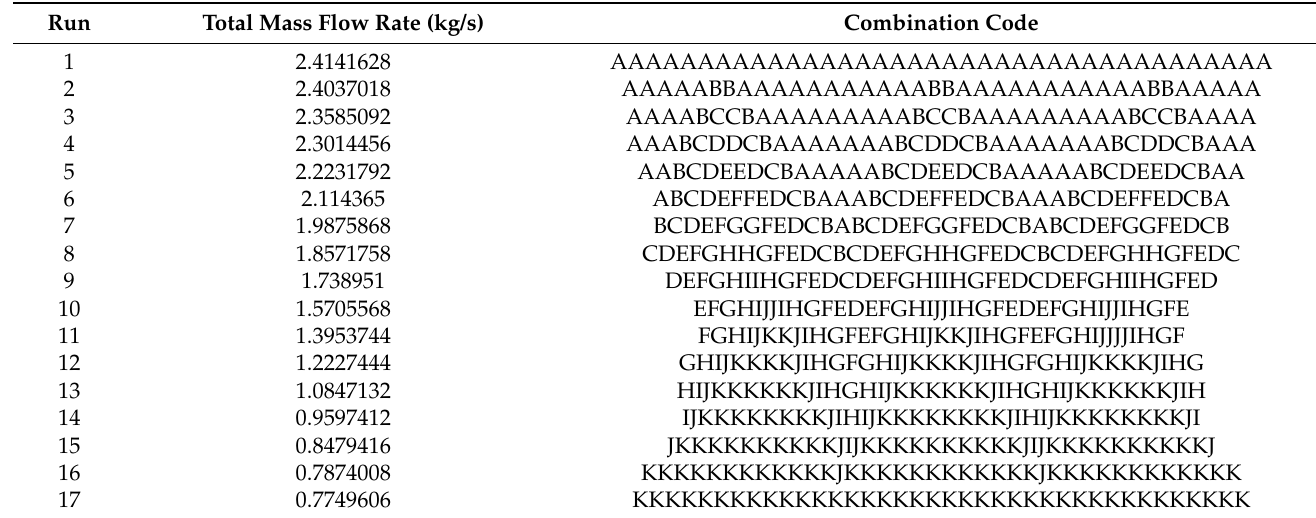
Table 4. Combinations of mass flow rates for three stall